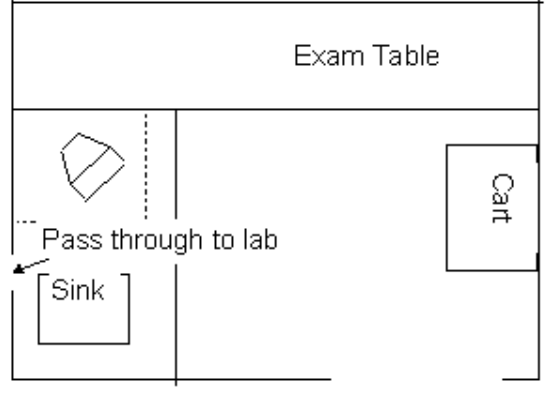
Figure 4-1. Floor plan for phlebotomy